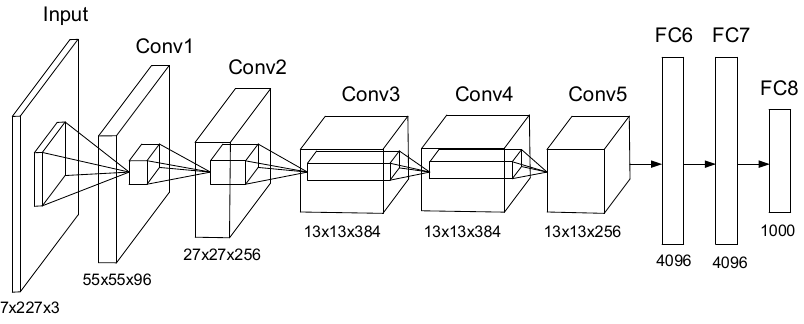
Figure 2. Architecture of AlexNet.